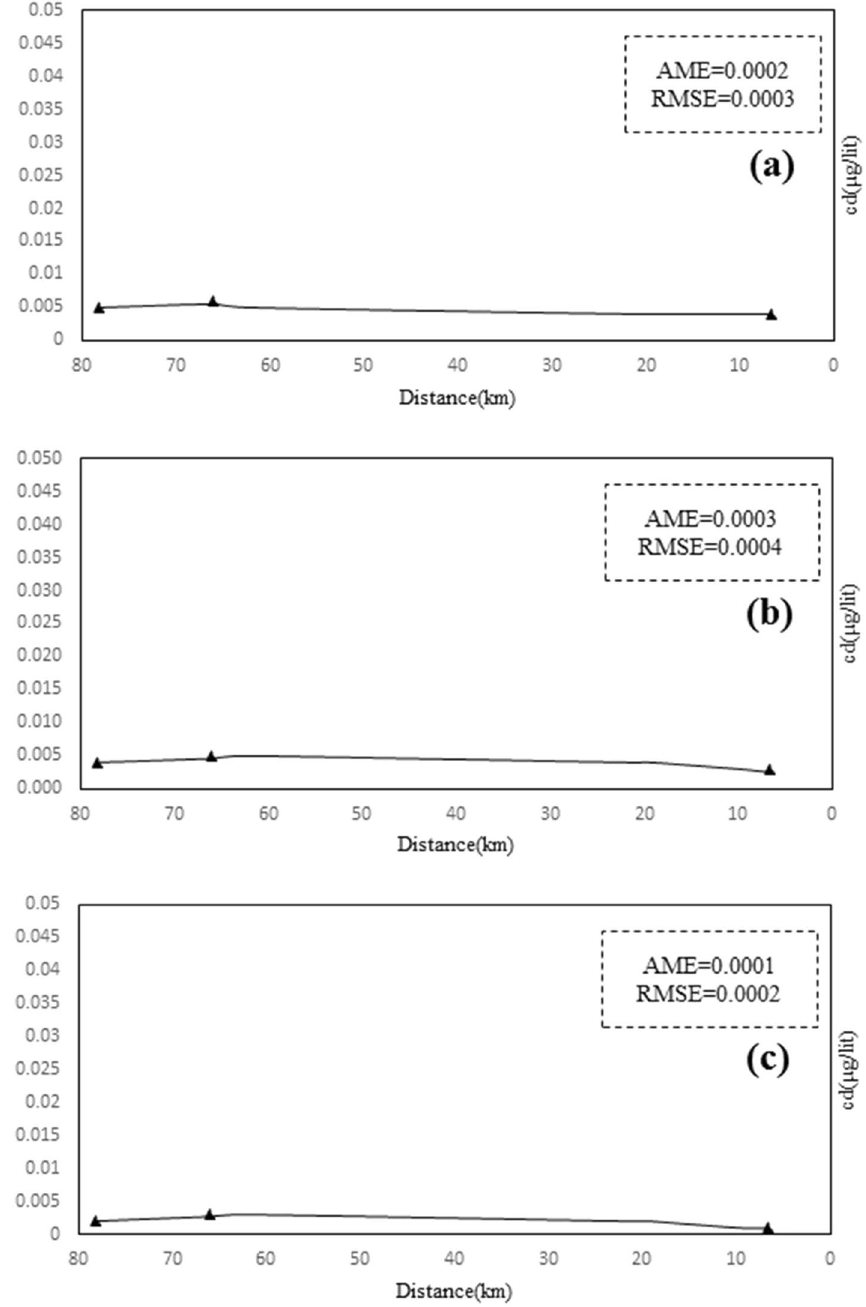
Figure 12. Cd Concentration on Sarouq River in ( a ) spring, ( b ) autumn, ( c ) winter in the developed Qual2kw